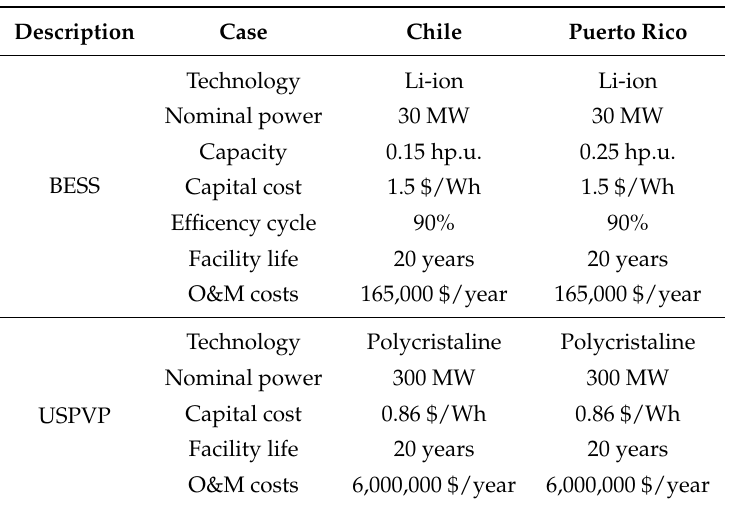
Table 6. USPVP and BESS settings.